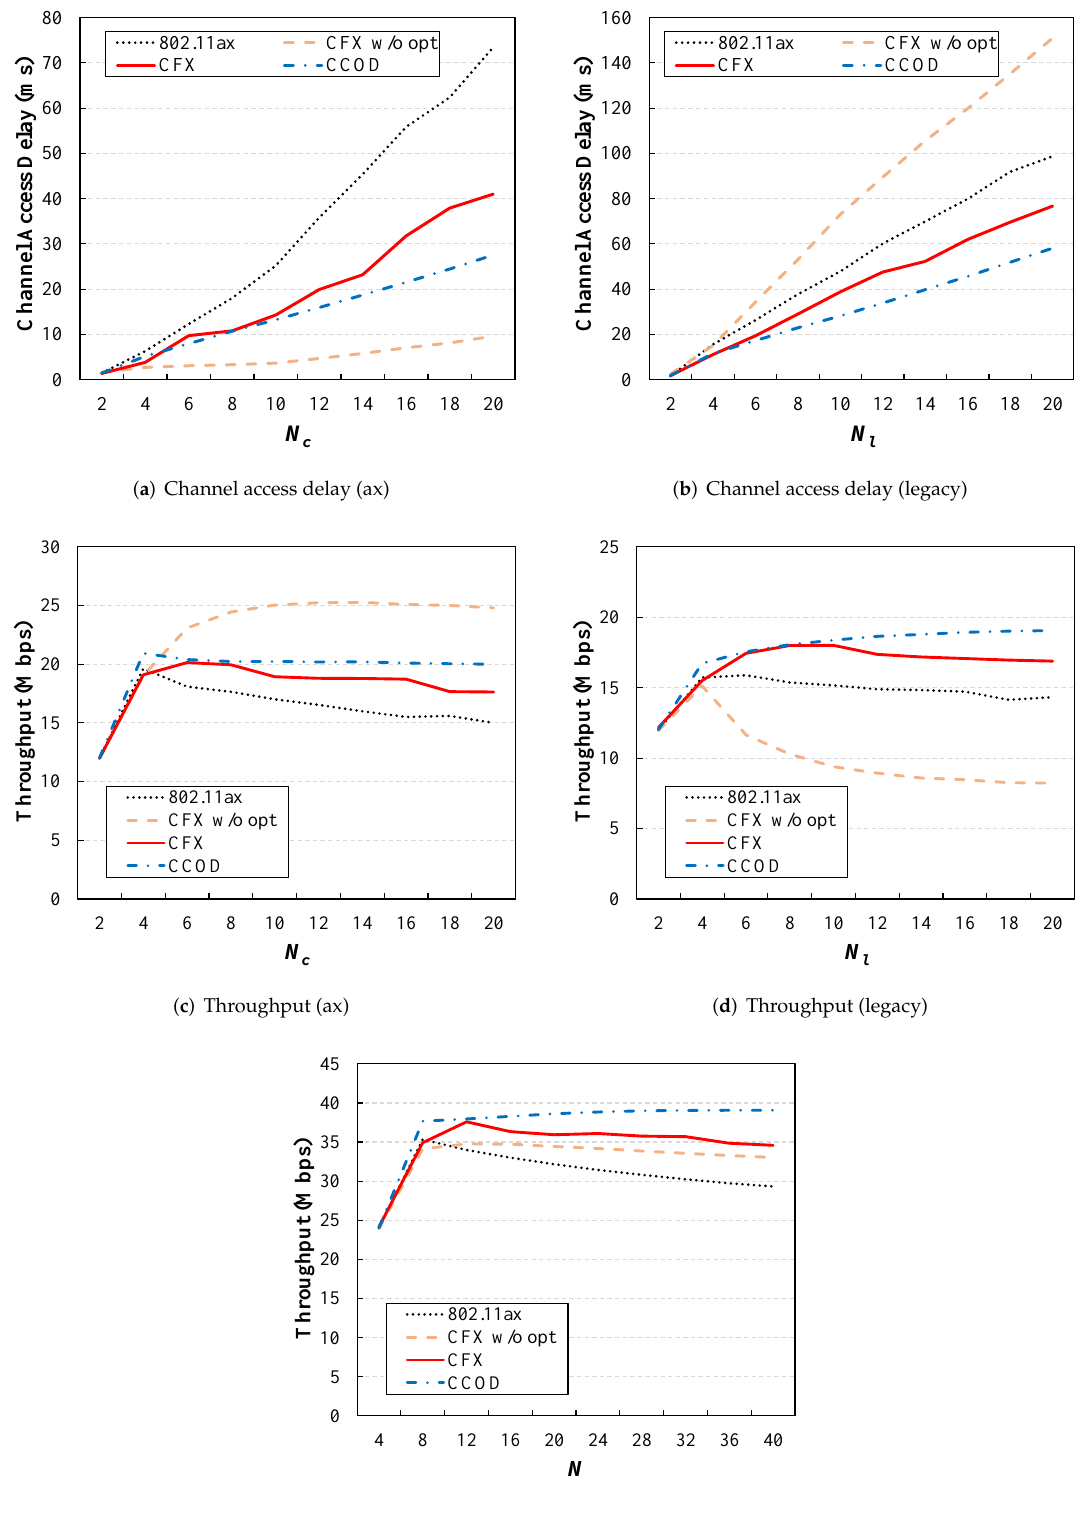
Figure 6. Throughput and channel access delay for the four schemes as a function of 𝑁 . CFX achieved higher performance than the conventional 802.11ax in terms of both total throughput ( c – e ) and channel access delay ( a , b ). When optimization was not applied, CFX tended to work favorably only for ax users, causing an unfairness